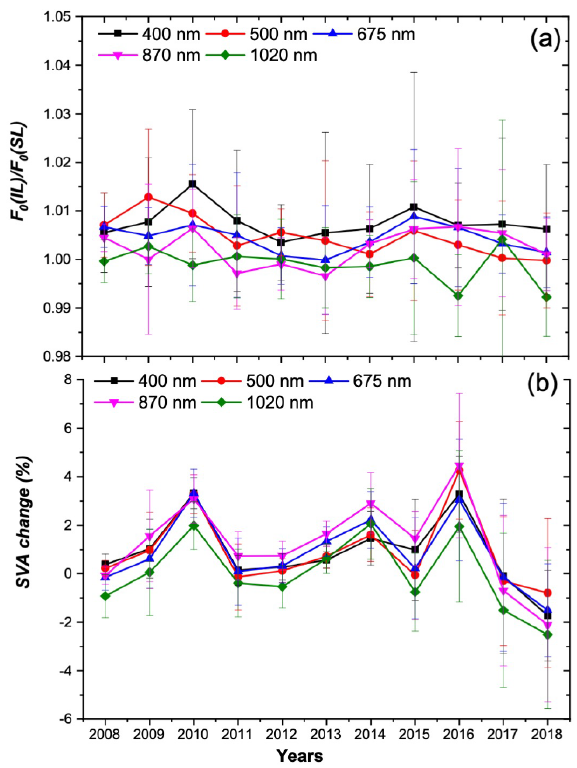
Figure 4. Time series of the ratio of F 0 values from SL and IL methods (a) and SVA (b) from the observations taken by a single in- strument (POM-01) at two pristine sites, IAO-Hanle during January 2008–December 2010 and June 2015–December 2018 and Merak during January 2011–May 2015. The error bar indicates a represen- tative monthly RMSD in each